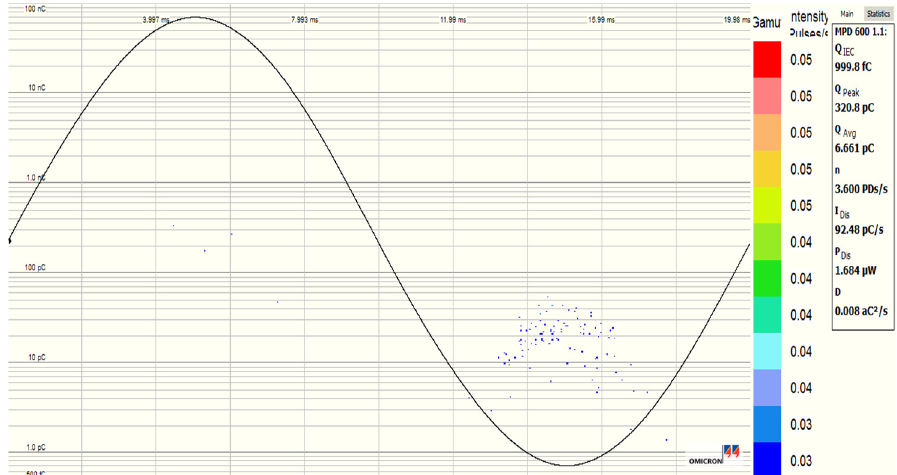
Figure 23. PD pattern of synthetic ester-based NF with Al 2 O 3 (50 nm, 0.4 g/L) at 13 kV (RMS) voltage level.